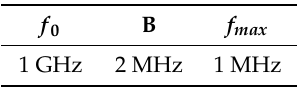
Table 1. Fixed simulations parameters.